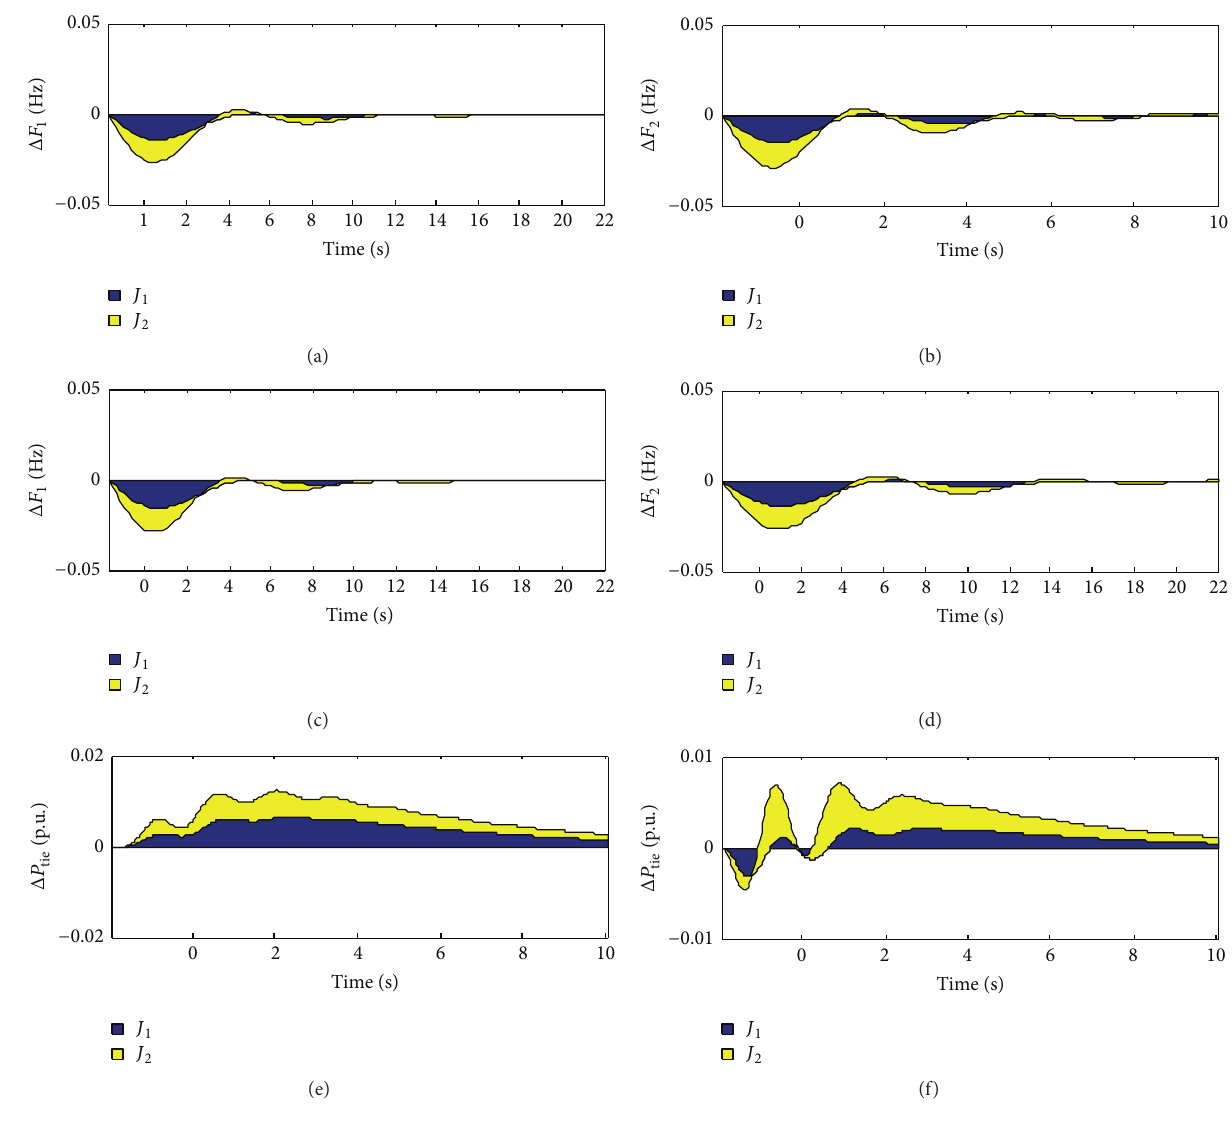
Figure 3: Dynamic responses obtained from